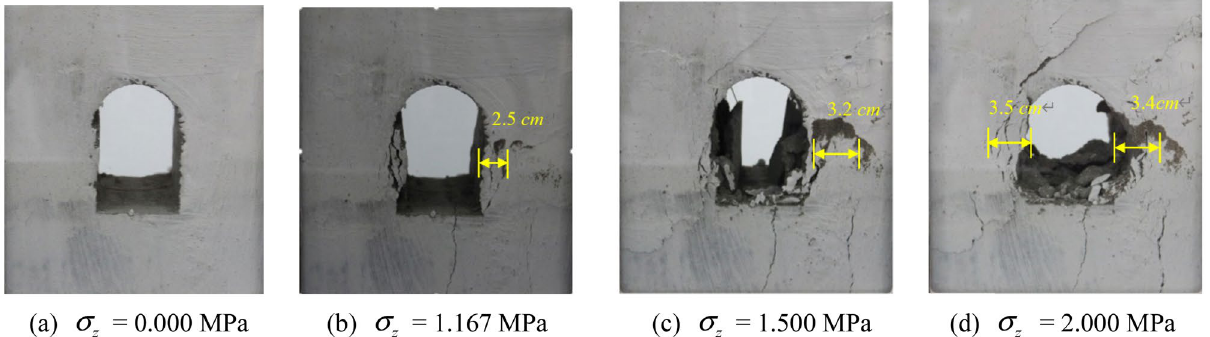
Figure 4. Fracture propagation in the tunnel model during the loading testing.